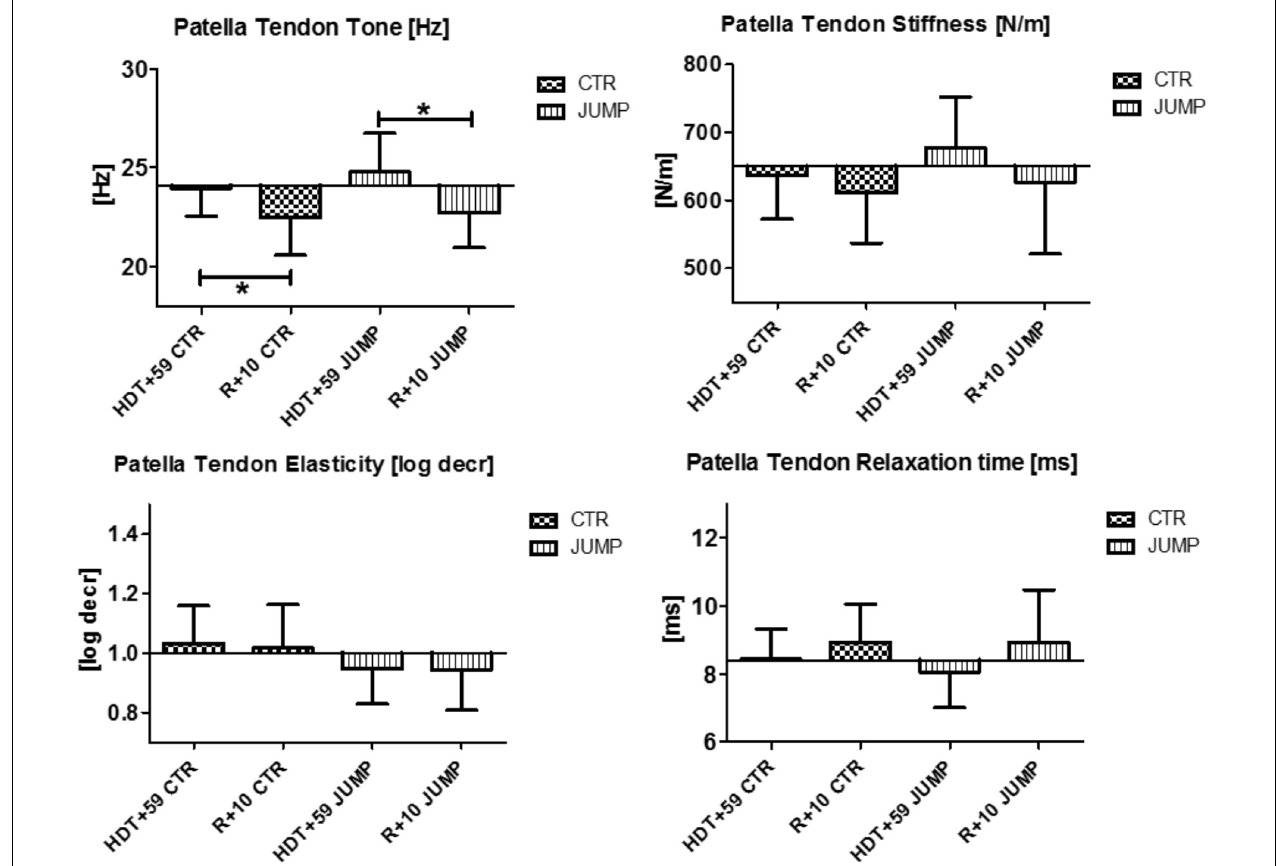
FIGURE 4 | Patellar Tendon (MP7/8). Oscillation signal patterns in RSL bed rest study. ABD, average baseline data (Tone HDT+1 = 24.1; Stiffness HDT+1 = 650.3; Elasticity HDT+1 = 1.0; Relaxation HDT+1 = 8.4). ∗ p < 0.05 ± SD, +Spearman ρ